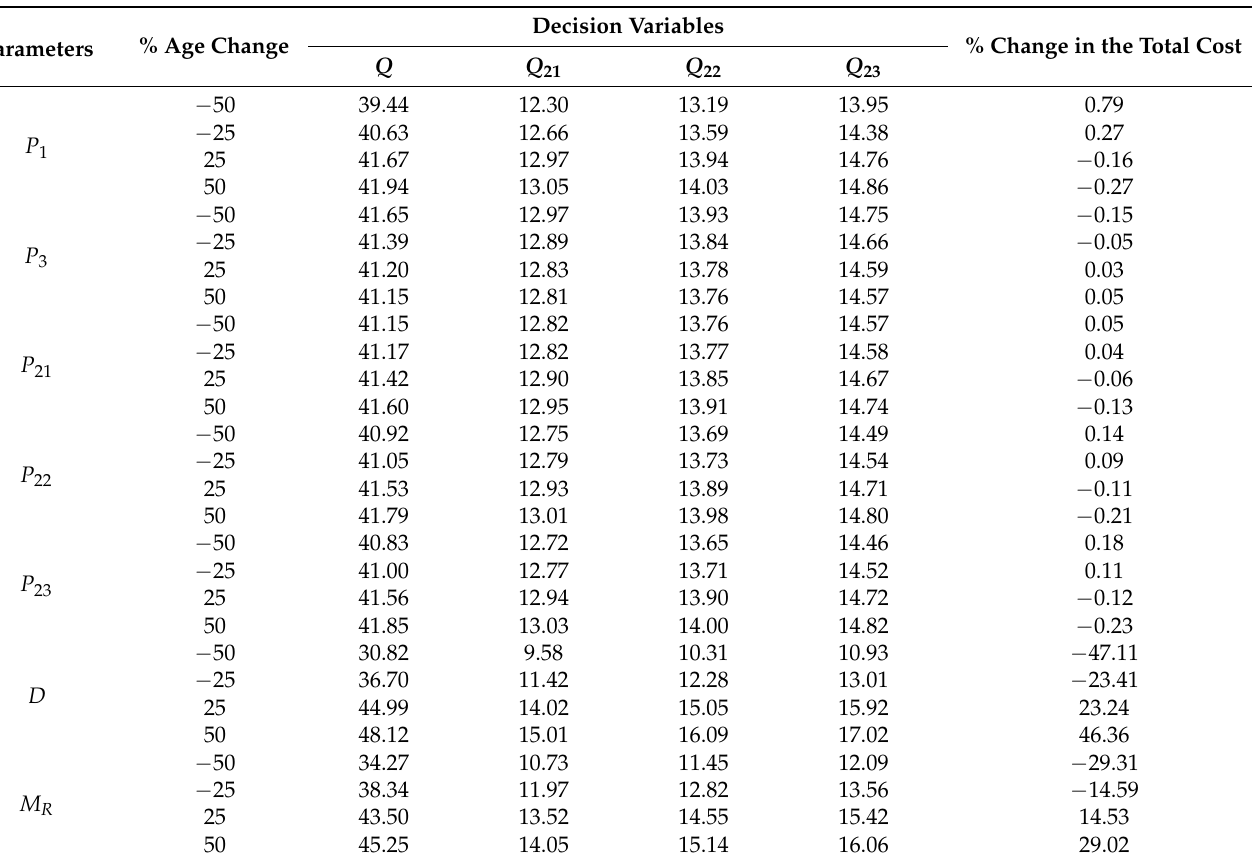
Table A6. Sensitivity analysis for demand, marginal, and production rate of manufacturer and outsourcers.